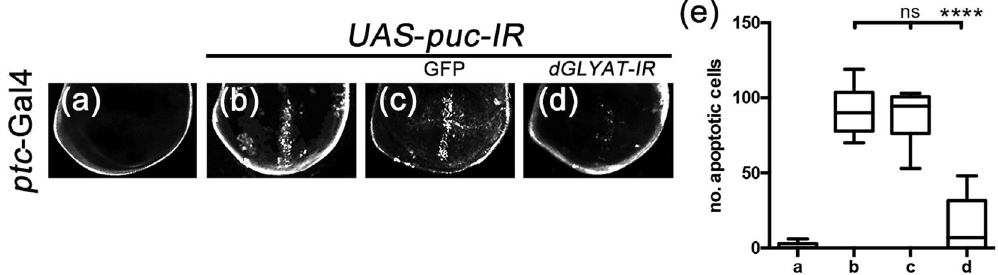
Figure 7. d GLYAT modulates loss of puc -induced cell death in wing discs. Light micrographs of Drosophila third instar wing discs ( a–d ) are shown. Compared with ptc -Gal4 controls ( a ), depletion of puc along the A/P boundary induces cell death in wing discs ( b ), which is suppressed by expressing a dGLYAT-IR ( d ), but remains unaffected by expressing GFP (c). ( e ) Statistics of the AO-positive cell numbers shown in ( a–d ) (a, n = 8; b, n = 8; c, n = 6; d, n = 9), n.s., P > 0.05; **** P < 0.0001.